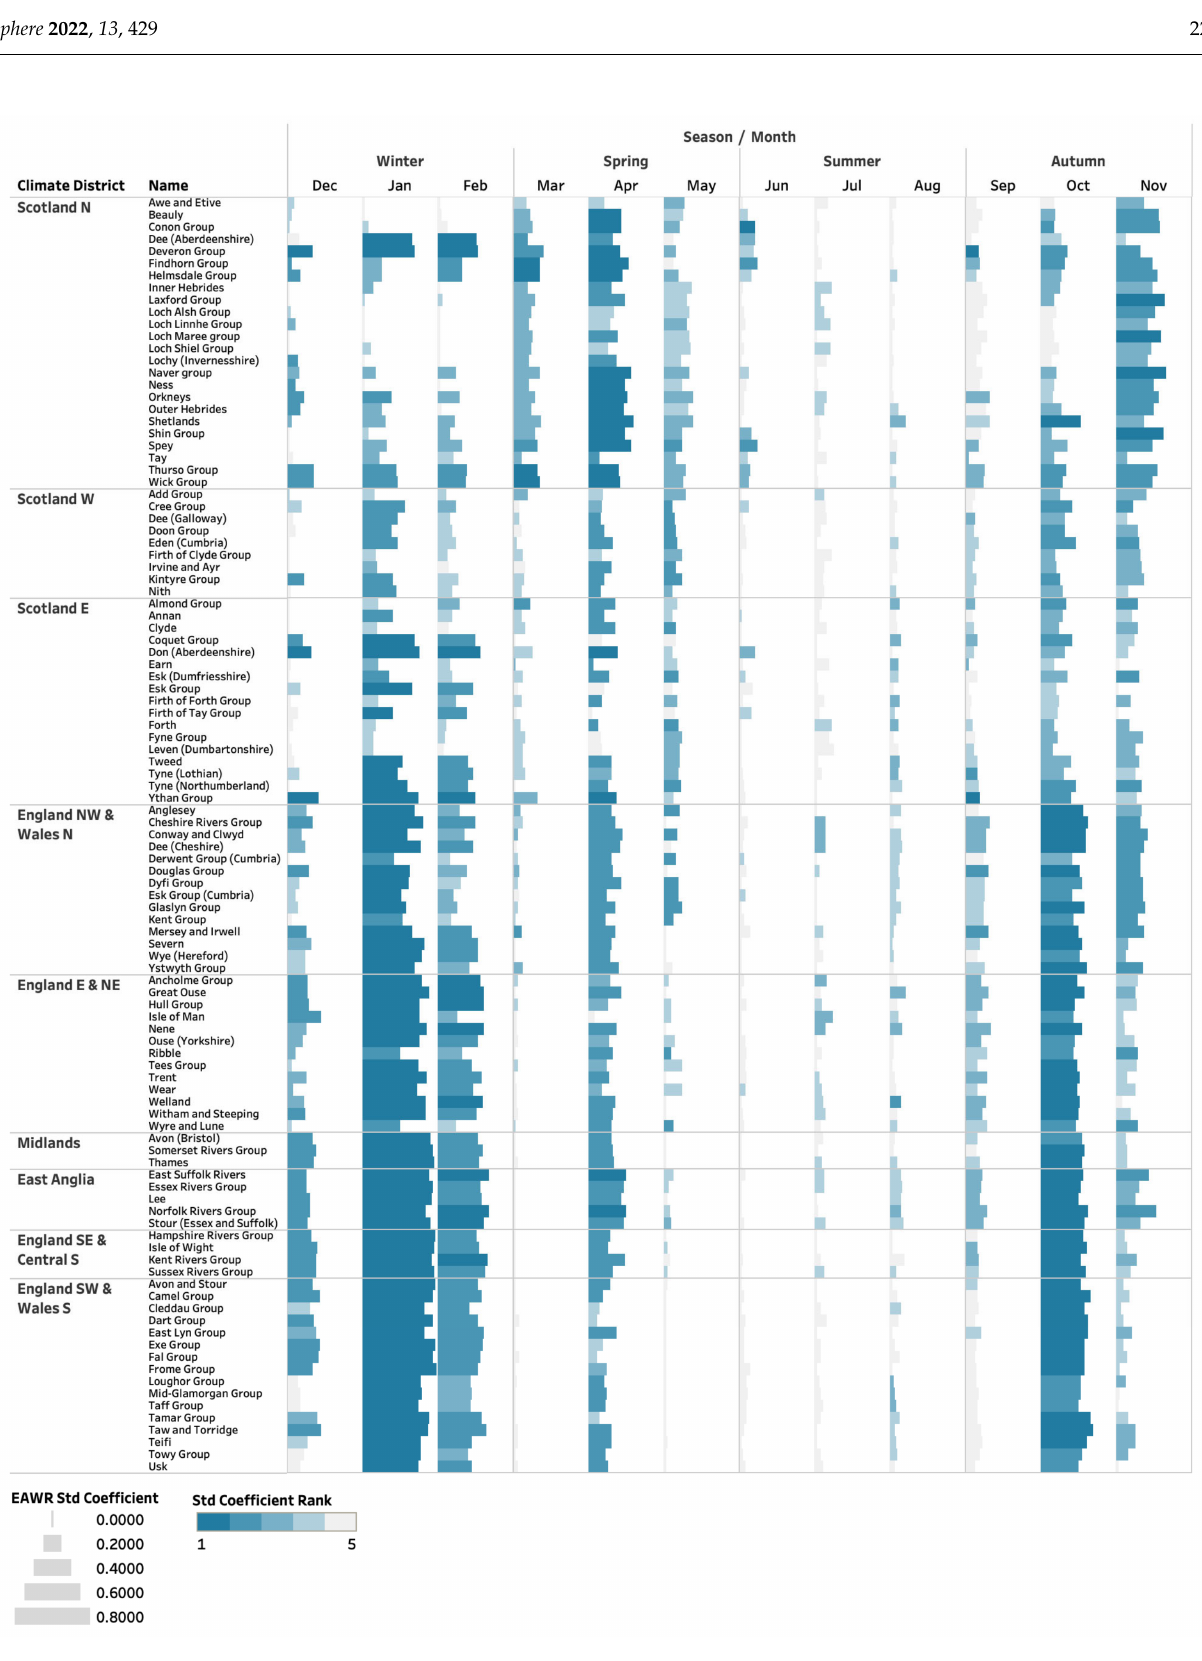
Figure A7. Rank of the EAWR Standardised Coefficient. Colour represents the rank, with darker colours signifying greater influence (higher rank). Size is dependent on the magnitude of the